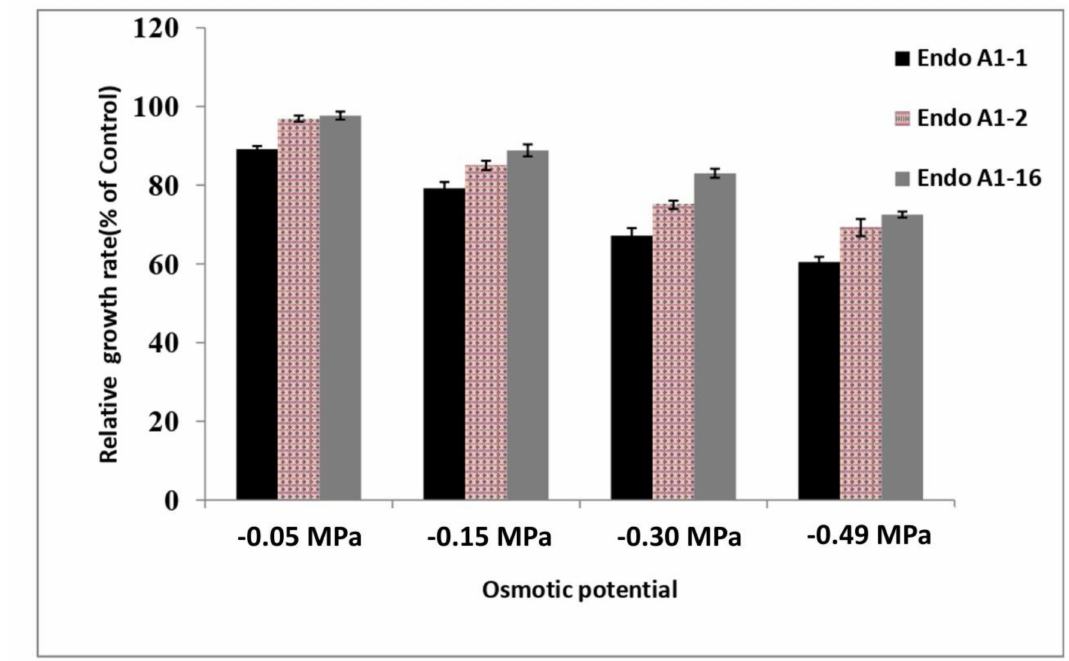
Figure 2. Effect of drought stress ( − 0.05 to − 0.49 MPa) on the growth of bacterial isolates in the nutrient broth supplemented with 5–20% of PEG. Results expressed as % growth relative to the isolates grown in the nutrient broth not amended with PEG6000. The values are the means of three replicates ± standard deviation ( n =